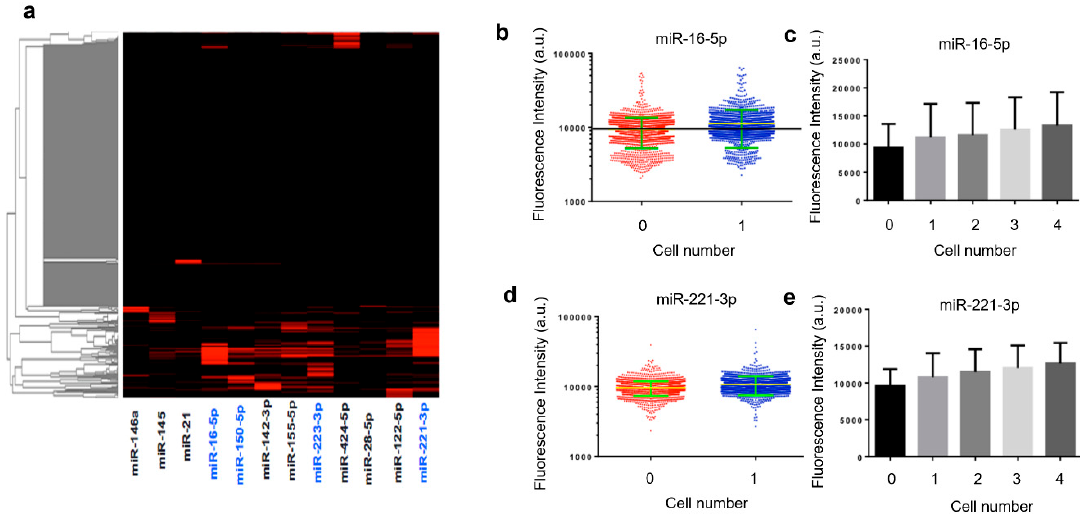
Quantification of single THP-1 cell microRNA detections. ( a ) Heatmap showing the expression of 13 microRNAs detected in single THP-1 cells isolated in microtroughs. The higher intensity indicates the higher expression level of the miRNA of interest. The ones (in blue) shown with relatively high expression and frequency are further validated with population or single cell comparative experiments. ( b ) Single cell expression intensity of miR-16-5p; ( c ) expression level of miR-16-5p increases with cell number in each microtrough; ( d ) single cell expression intensity of miR-221-3p; ( e ) expression level of miR-221-3p increases as cell number in each microtrough increases.